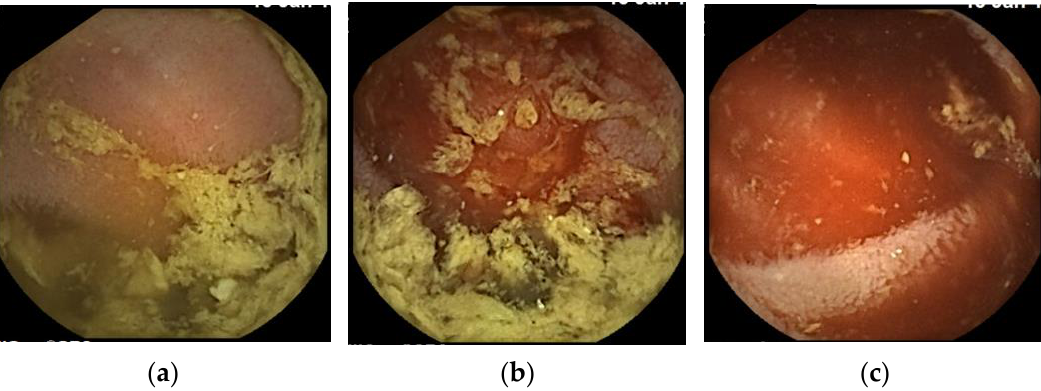
Figure 3. Small bowel capsule endoscopy findings at third examination. ( a ): Yellow and transparent intestinal fluid; ( b ): Boundary where the color of the intestinal fluid changes. Intestinal fluid on the proximal side to the boundary is yellow and transparent, while that on the distal side is bloody; ( c ): Bloody intestinal fluid.